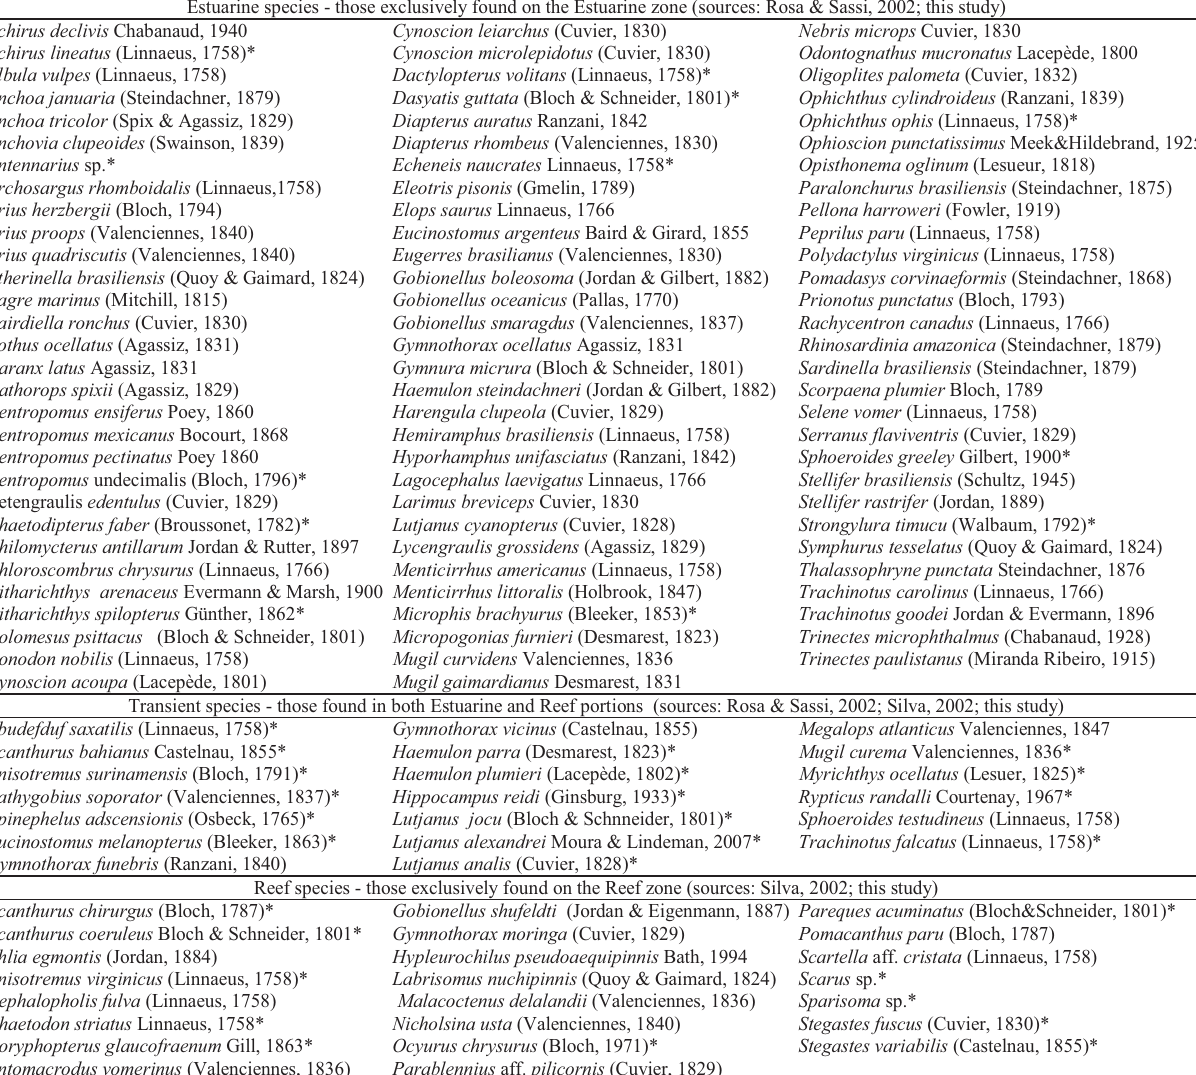
Table 6. Fishes recorded along the Mamanguape Mangrove-Reef system, State of Paraíba, NE Brazil, according to the zone where they occurred. Species that occurred in our study are marked with an